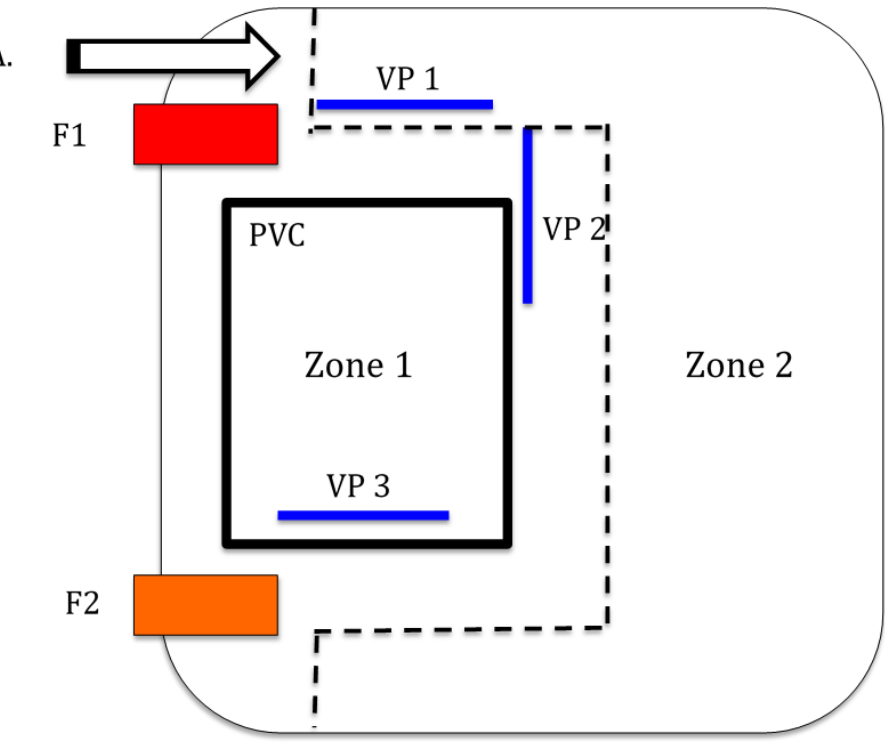
Figure 1. Top view of the tank with physical enrichment and showing parts of the tank that differ by the luminosity (zone 1–5 Lux vs. zone 2–20 Lux) due to the cover with PVC plank (PVC). The zones are delimited by the dash line. The surface of zone 1 was larger than the surface of the planks because it projects shadow on the bottom of the tank. W.A. = water arrival; F1, F2 = automatic feeders; VP1, VP2, VP3 = vertical pipes.